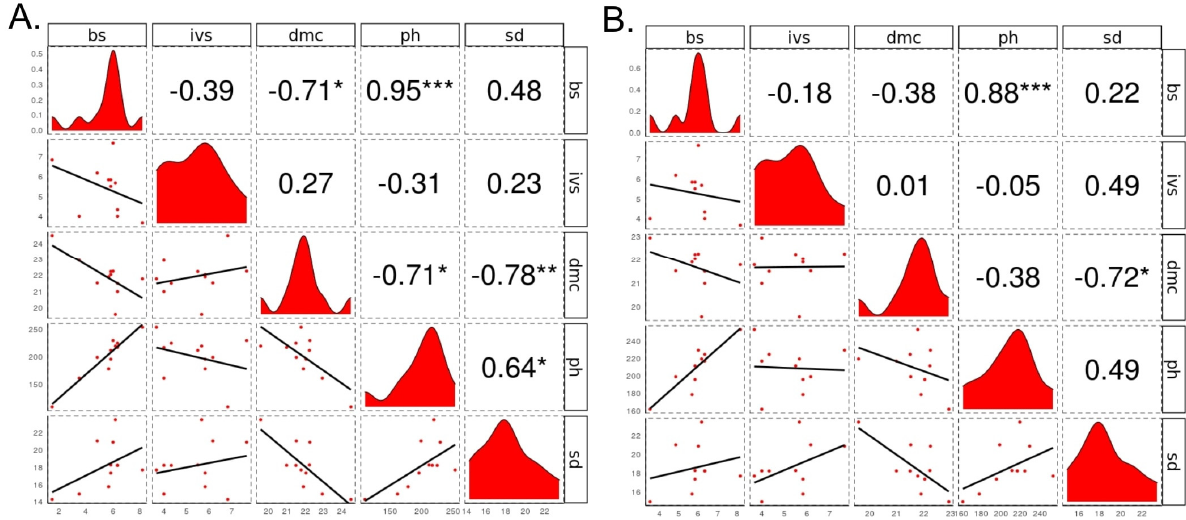
Figure 3. Pearson’s correlation coefficients between biomass yield components, based on the adjusted genotype means over two locations. Bärnkrafft is ( A ) included and ( B ) excluded. Traits are bs, biomass score; ivs, inflorescence volume score; dmc, dry matter content; ph, plant height and sd, stem diameter. *, **, *** significant at p < 0.05, p < 0.01 and p < 0.001 respectively.